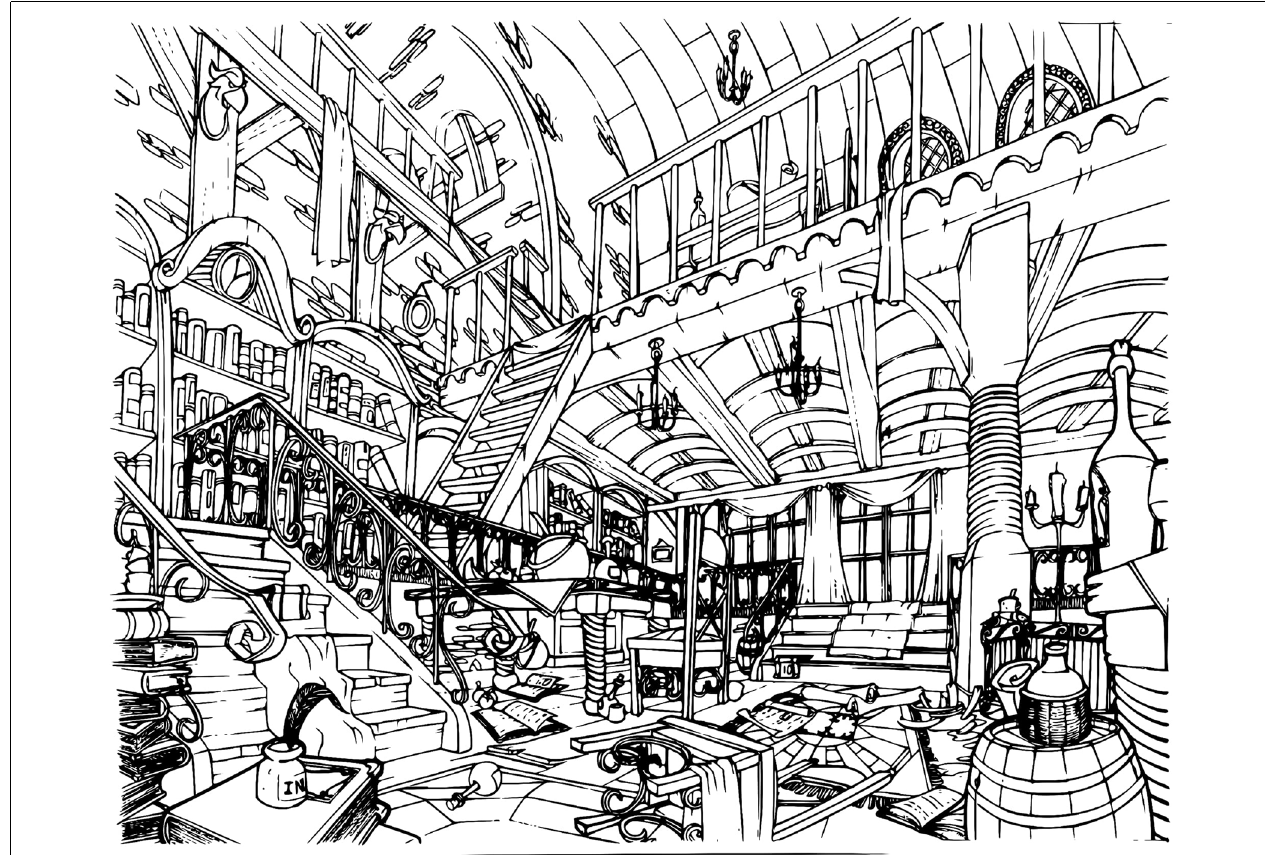
FIGURE 6 | Left panel. Artwork by Benoit Tranchet (reproduced with